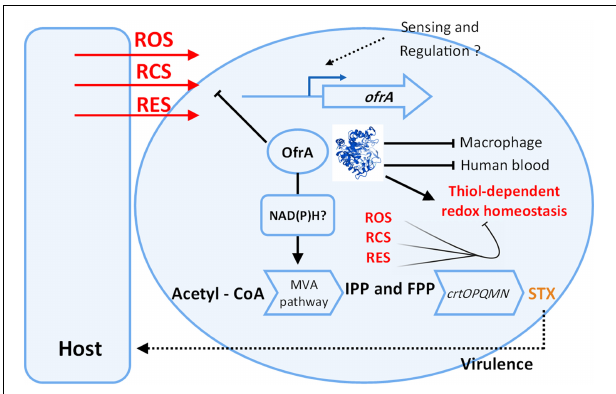
FIGURE 7 | Cartoon representation shows our current understanding of ofrA function in S. aureus . OfrA protein 3D structure was predicted via AlphaFold. For 3D visualization, refer to alphafold.ebi.ac.uk/entry/Q2FZU7. ofrA is induced in ROS, RES, and RCS conditions which are available at the host- S. aureus interface. We showed that ofrA is an important factor in S. aureus resistance to the aforementioned stress conditions. ofrA contributes to S. aureus virulence via human blood and macrophage survival. ofrA mutation is involved in decreased STX production via MVA pathway. Both STX and ofrA protects S. aureus against oxidative stress via different mechanisms. ofrA supports the thiol-dependent redox homeostasis. FPP, farnesyl pyrophosphate; IPP, isopentenyl pyrophosphate; MVA, mevalonate; STX,